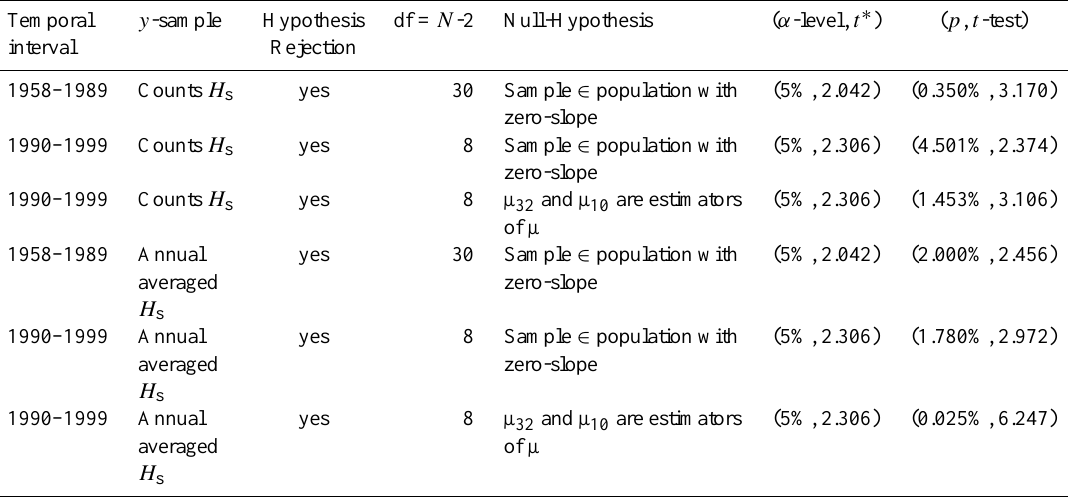
Table 2. Five tests of significance based on Student’s t distributions with N -2 degrees of freedom (df) and mean µ x . Symbols µ, µ 32 and µ 10 indicate the population mean and the µ-estimators of the 32-and 10-years samples.